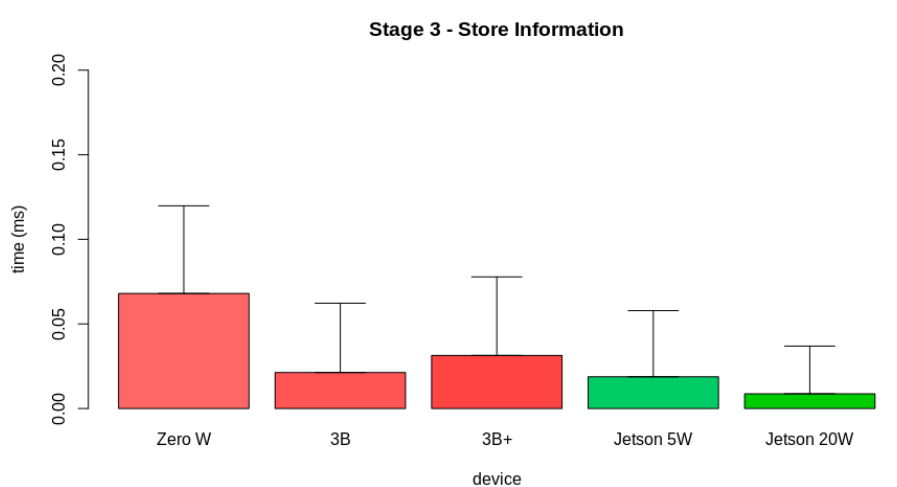
Figure 19. Latency results for the second stage.